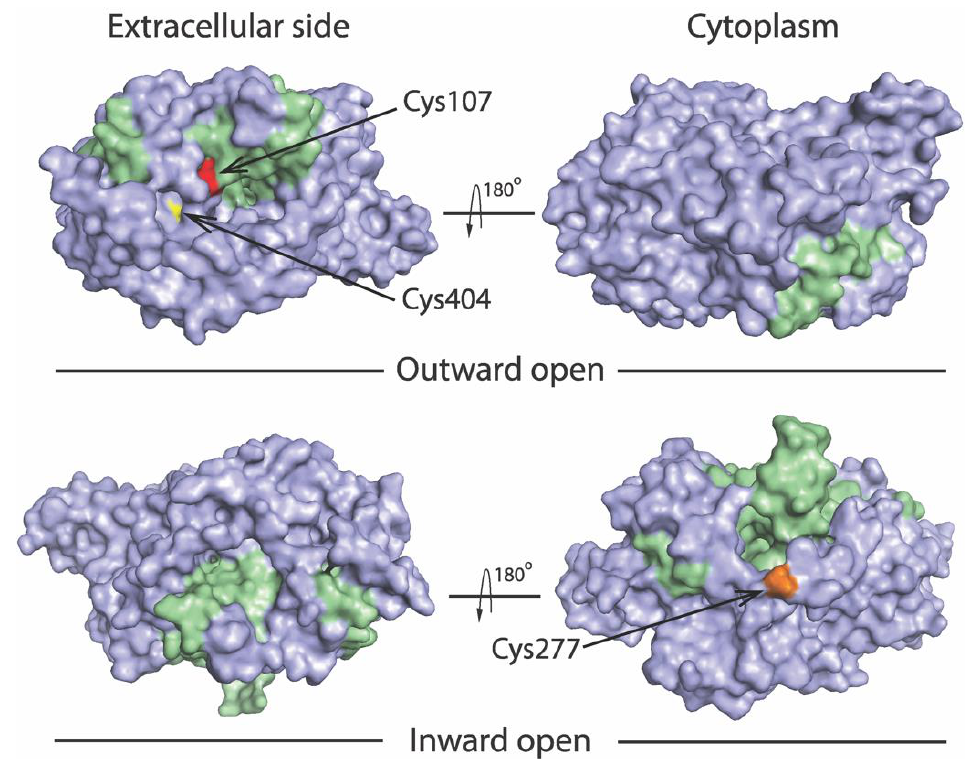
Figure 2. Location of the cysteine residues used to probe pathway accessibility. Views of the outward open (PDB ID code 7LIA) and the inward open (PDB ID code 7LI9) SERT structures [25] are shown from extracellular side ( left ) and cytoplasm ( right ). The bundle domain (TMs 1, 2, 6, and 7) and other part of the protein are colored green and gray, respectively. The modified residues Y107C (red), S404C (yellow), and S277C (gold) are shown to illustrate accessibility of Cys107 and Cys404 to the extracellular pathway, and Cys277 to the cytoplasmic pathway. Table 1. Kinetic parameters of WT-SERT and cysteine